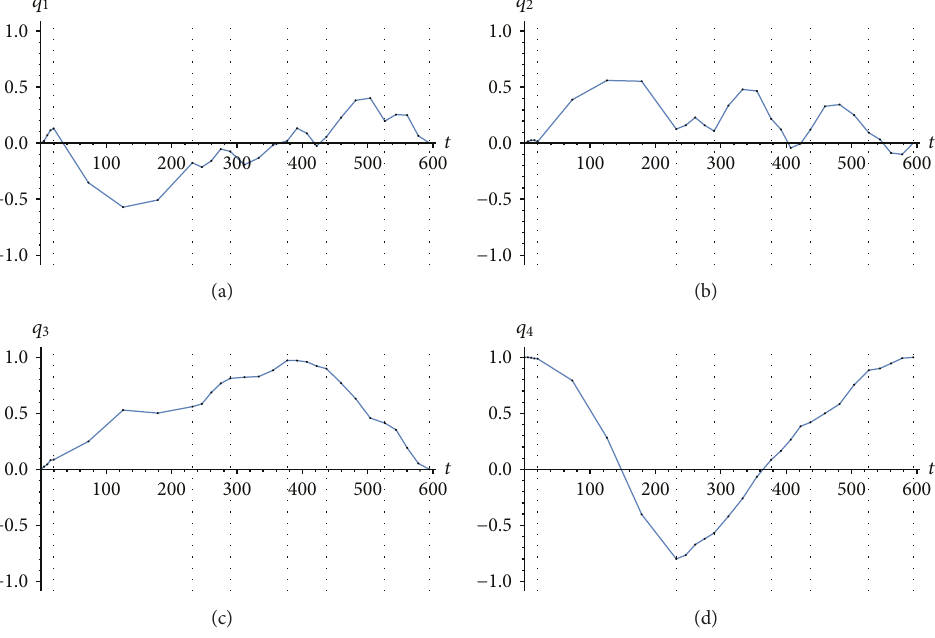
Figure 3: Quaternions in experiment A with 6 target attitudes.